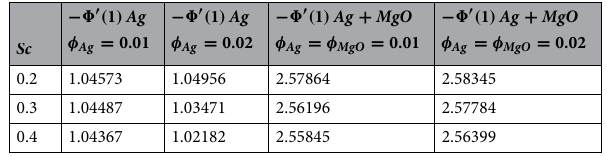
Table 5. Numerical outputs of Sherwood number − � ′ ( 1 ) at the surface of cone.